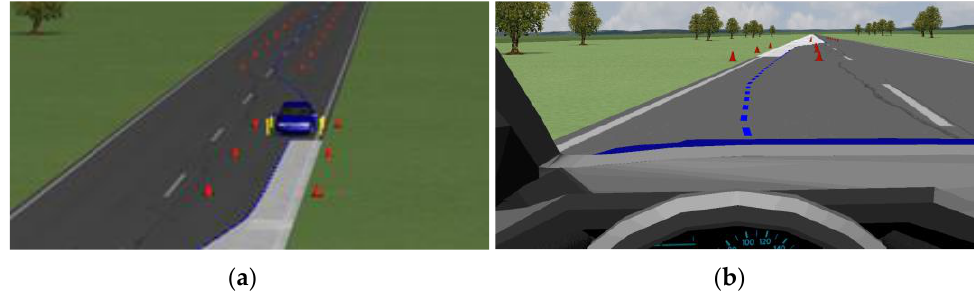
Figure 6. The μ -split road. ( a ) top view. ( b ) driver view. Figure 6. The µ -split road. ( a ) top view. ( b ) driver